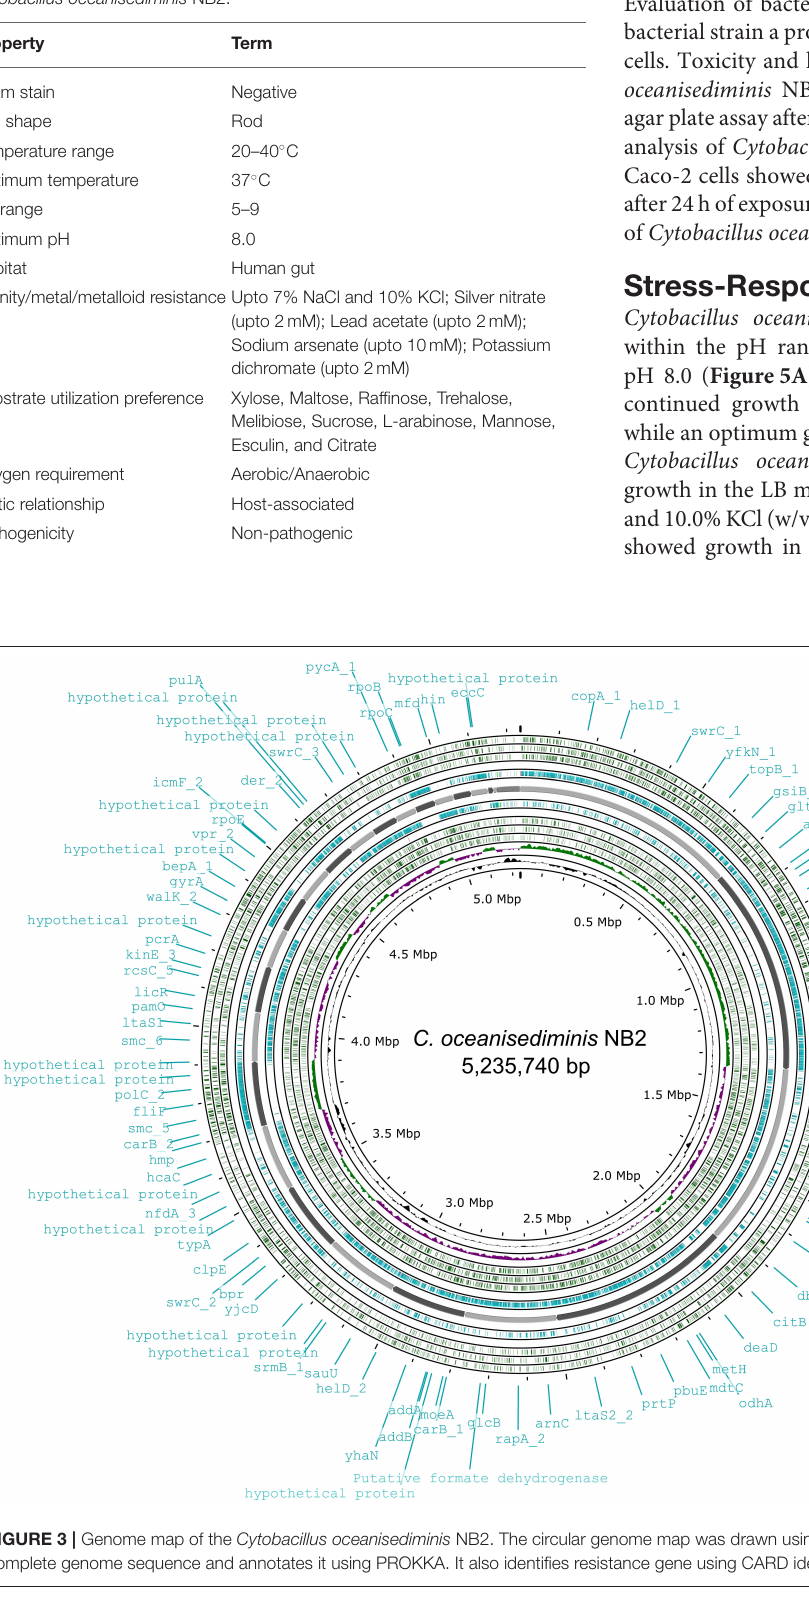
Frontiers in Microbiology |